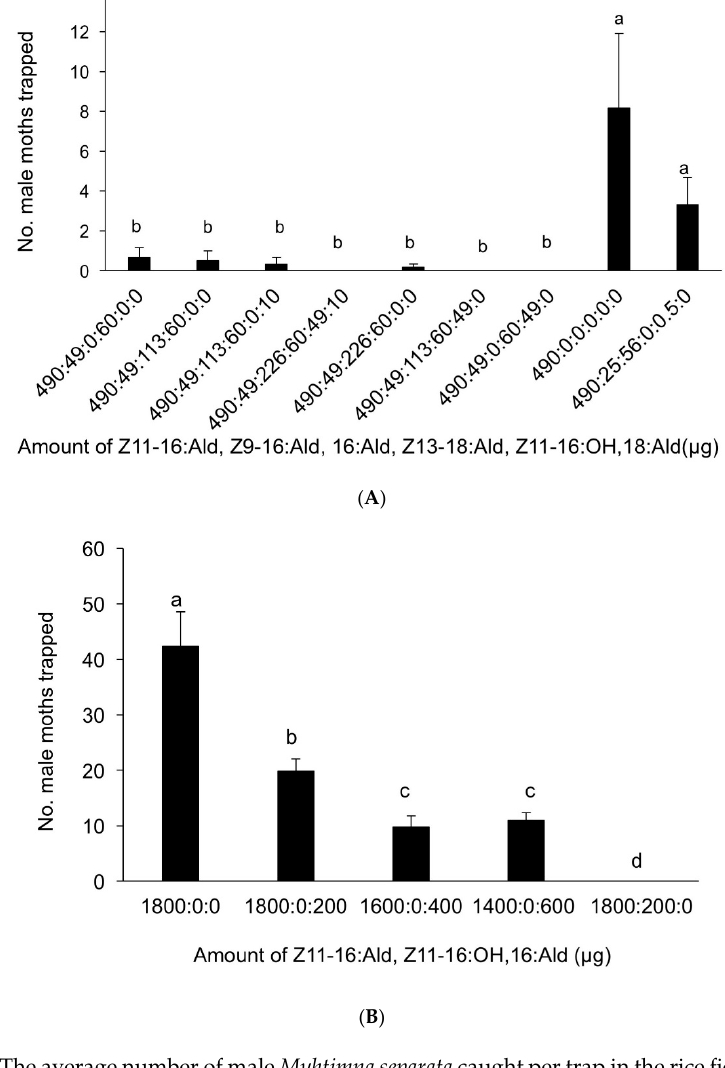
Figure 8. ( A ) The average number of male Myhtimna separata caught per trap in the rice fields in Ningbo, Zhejiang (10 September–22 September 2012), by lures made up of mixed blends of the pheromone components Z11-16:Ald, Z9-16:Ald, Z13-18:Ald, 16:Ald, Z11-16:OH, 18:Ald, in the ratios indicated along the x axis. Each treatment was replicated six times. Treatment bars represent the standard errors; bars with different letters above them are significantly different from each other in the number of male moths captured ( p < 0.05). ( B ) The average number of male Mythimna separata caught per trap in the rice fields in Yuxi, Yunnan (10 June–22 June 2015), by lures made up of mixed blends of the pheromone components Z11-16:Ald, 16:Ald, and Z11-16:OH, in the ratios indicated along the x axis. Each treatment was replicated six times. Treatment bars represent the standard errors; bars with different letters above them are significantly different from each other in the number of male moths captured ( p < 0.05).